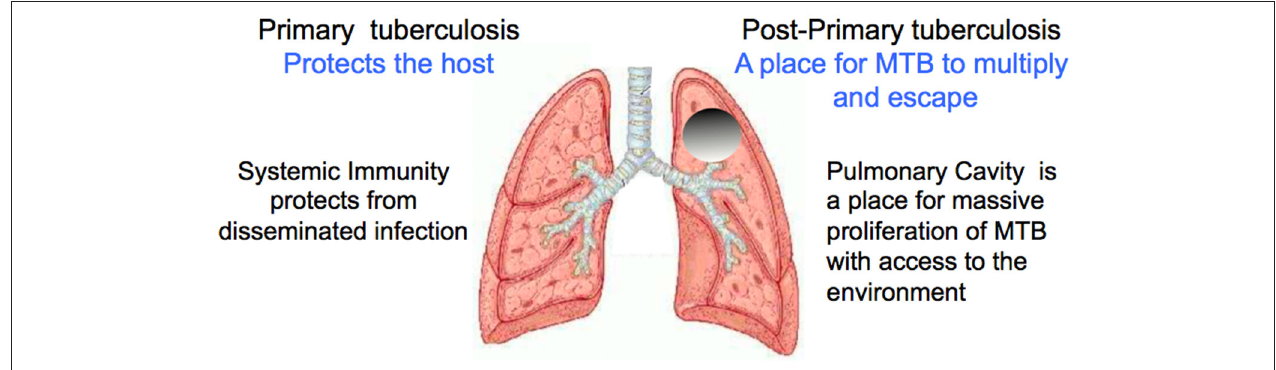
FIGURE 2 | Functions of primary and post-primary TB. The survival of this parasite depends on keeping its host alive while large numbers of organisms are produced and transmitted into the environment over a period of decades. Image modified from https://www.slideshare.net/saktivinayaga/trachea-lungs Dr Mohammed Faez, Department of Anatomy